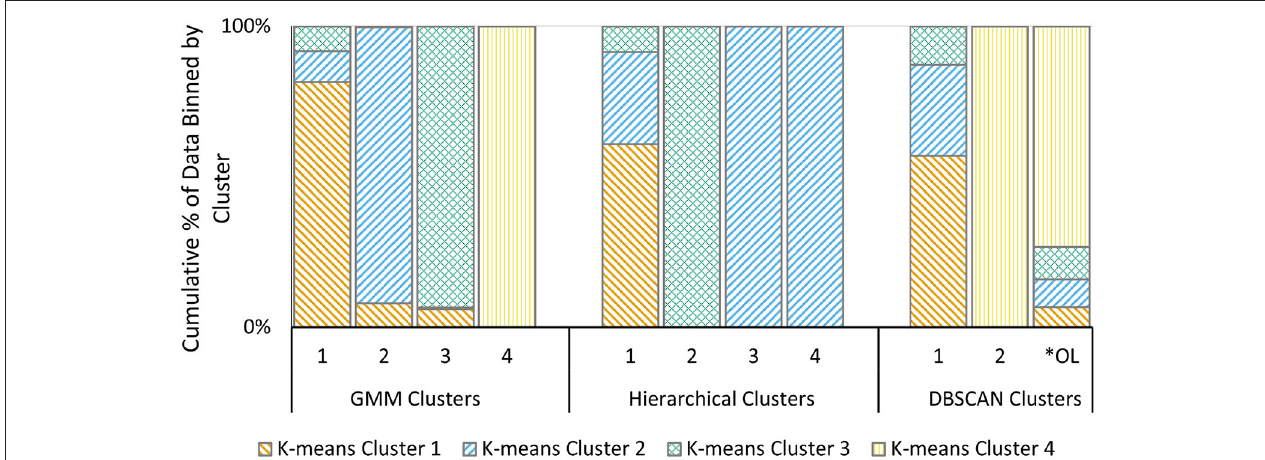
FIGURE 3 | Proportion of K-means clusters assigned to clusters generated by alternative techniques: GMM clustering, Hierarchical clustering, and DBSCAN clustering. *OL, Outliers.